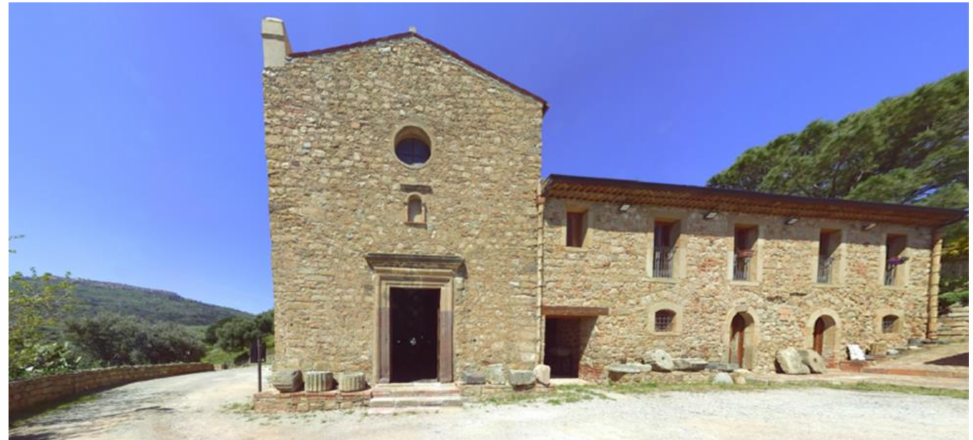
Figure 2. Façade of the church and the adjacent lapidarium .